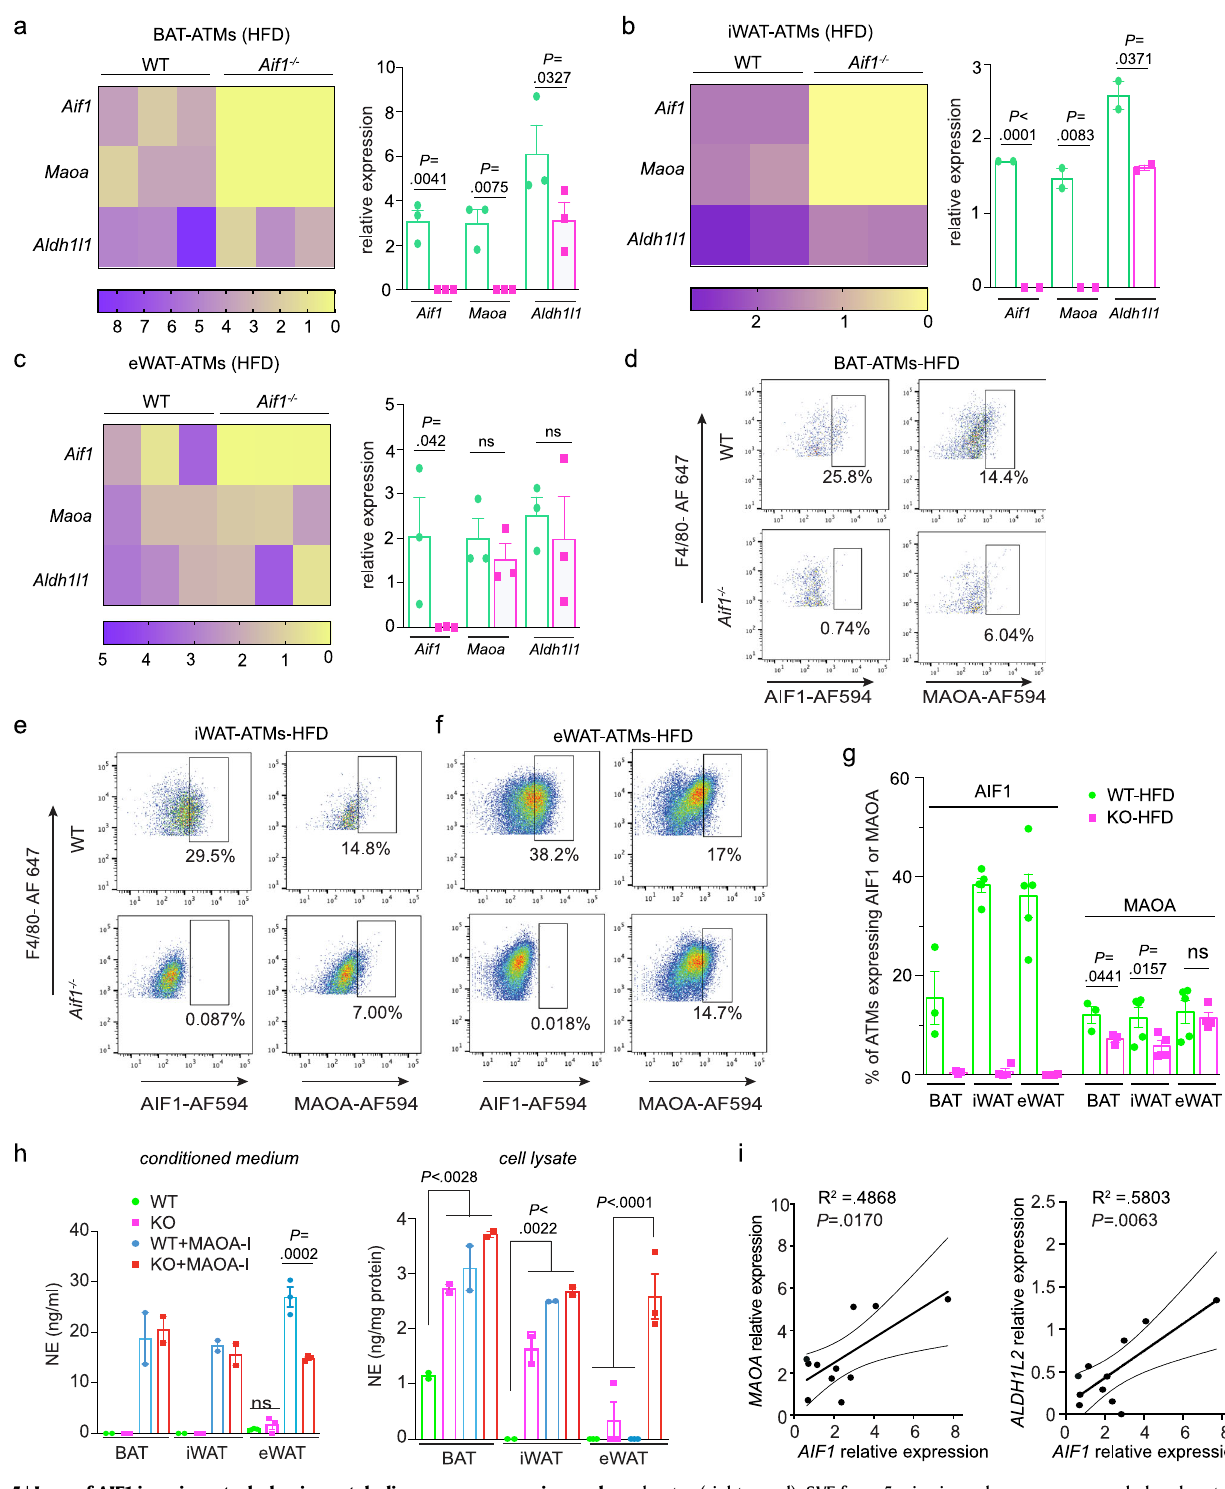
lysates (right panel); SVF from 5 mice in each group were pooled and sorted to obtain CD45+CD11b+F4/80+ cells, and NE was measured in 2 or 3 technical replicates).Dataarepresentedasmean±s.e.m.Statisticalsigni fi cancewasassessed by unpaired two-sided t -test ( a – c and g ) and two-way ANOVA using Tukey ’ s mul- tiple comparisons test ( h ). i Linear regression analysis of AIF1 and MAOA or ALDH1L2 expression in subcutaneous adipose tissues of clinical participants with excess weight or obesity ( n =11), with signi fi cance assessed by Pearson ’ s correla- tion. Curved lines indicate 95% con fi dence intervals. n represents a number of biologically independent animal or human participants unless otherwise noted. Source data are provided as a Source Data fi le.